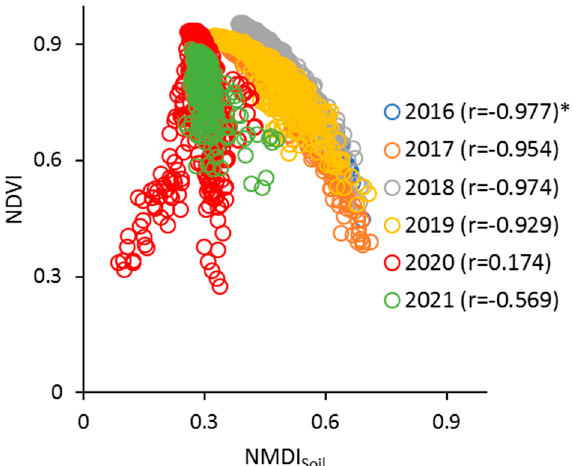
Figure 10. NMDI Soil vs. NDVI data for the month of July (2016–2021) (* Pearson correlation coefficient). Table 5. Regression model between NDVI and NMDI Soil for the month of July (2016–2021). Year Regression Models Regression